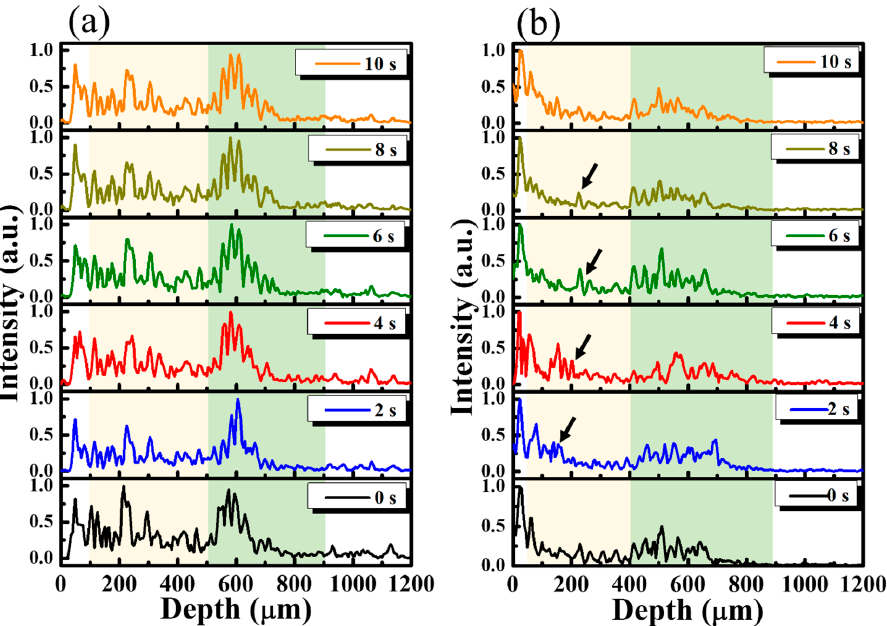
Figure 3. ( a ) Averaged A-scan profiles of the yellow line (the unexposed region) in Figure 2 and ( b ) the averaged A-scan profiles of the white line (the exposed region) in Figure 2 obtained at time points of 0, 2.0, 4.0, 6.0, 8.0, and 10.0 s after the drug application. The black arrows indicate the variation in OCT backscattered intensity after the drug application.